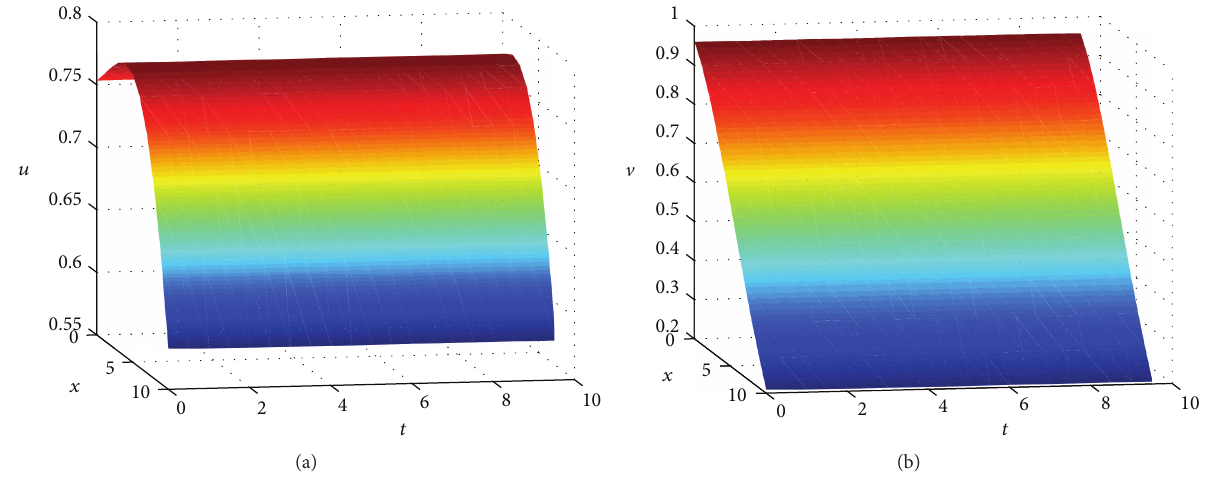
Figure 2: Numerical simulation for (5) with 𝑢 0 = cos (𝑥/10), V 0 = cos (𝑥/10)